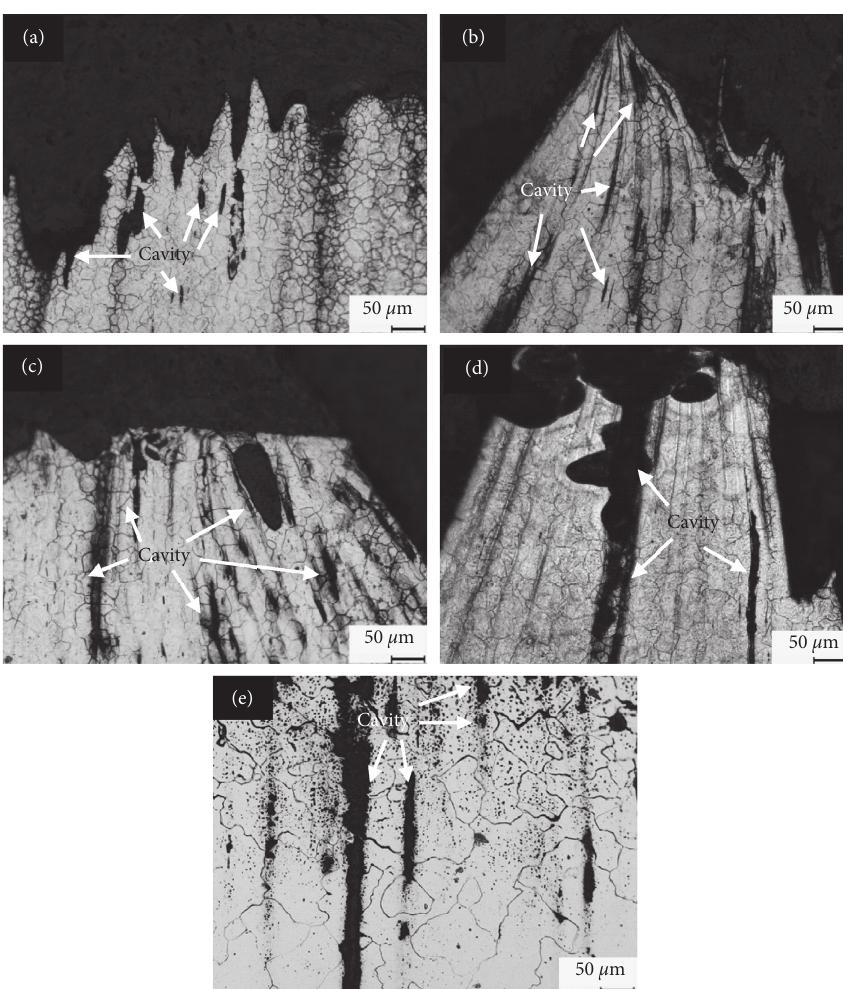
Figure 4: Microstructure in longitudinal section of fracture surface for sections at 1 s − 1 : (a) 1223 K. (b) 1273 K. (c) 1373 K. (d) 1423 K. (e) 1473